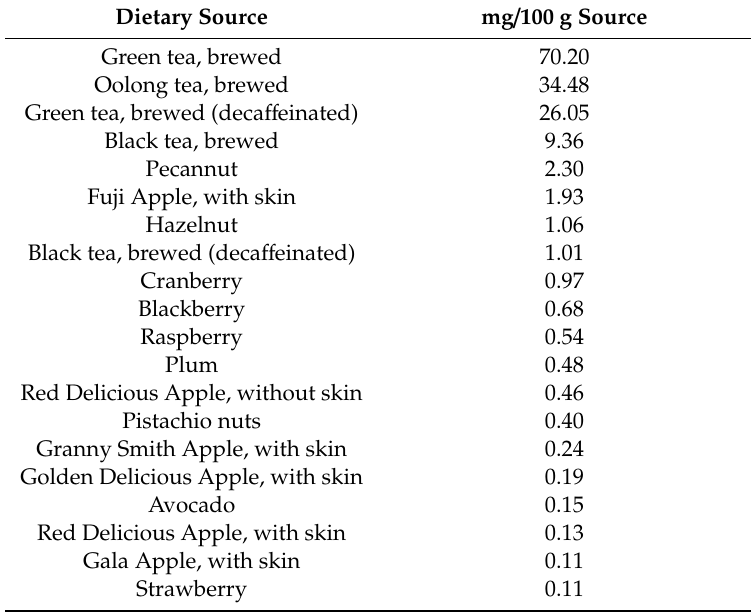
Table 1. Dietary sources of